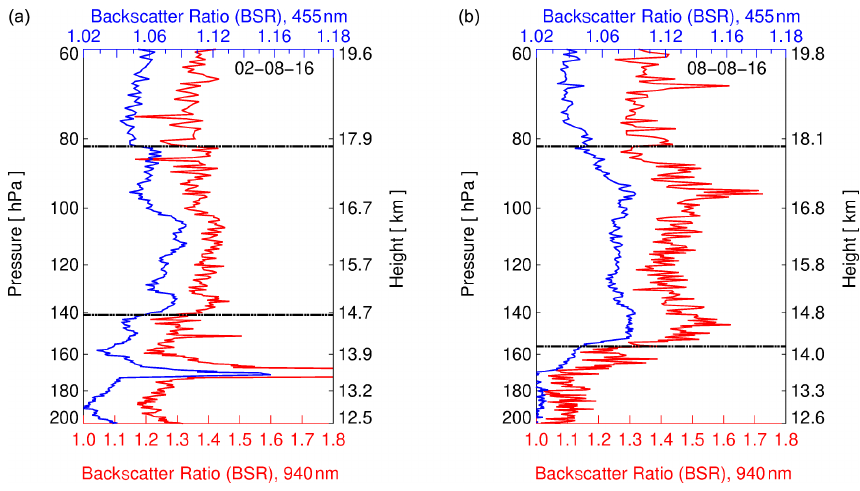
Figure A2. COBALD BSR 455 (blue) and BSR 940 (red) measurements in the UTLS region versus pressure (60–200hPa) for two flights in August 2016, (a) 2 August and (b) 8 August. The right-hand axis in both panels shows log-pressure height. Shown are the measured data in pressure bins without further processing (see main paper). The top and bottom boundaries of the ATAL (see Table 1 in the main paper) are marked by horizontal dashed–dotted black lines. (Note the different scaling for BSR 455 and BSR 940 .)